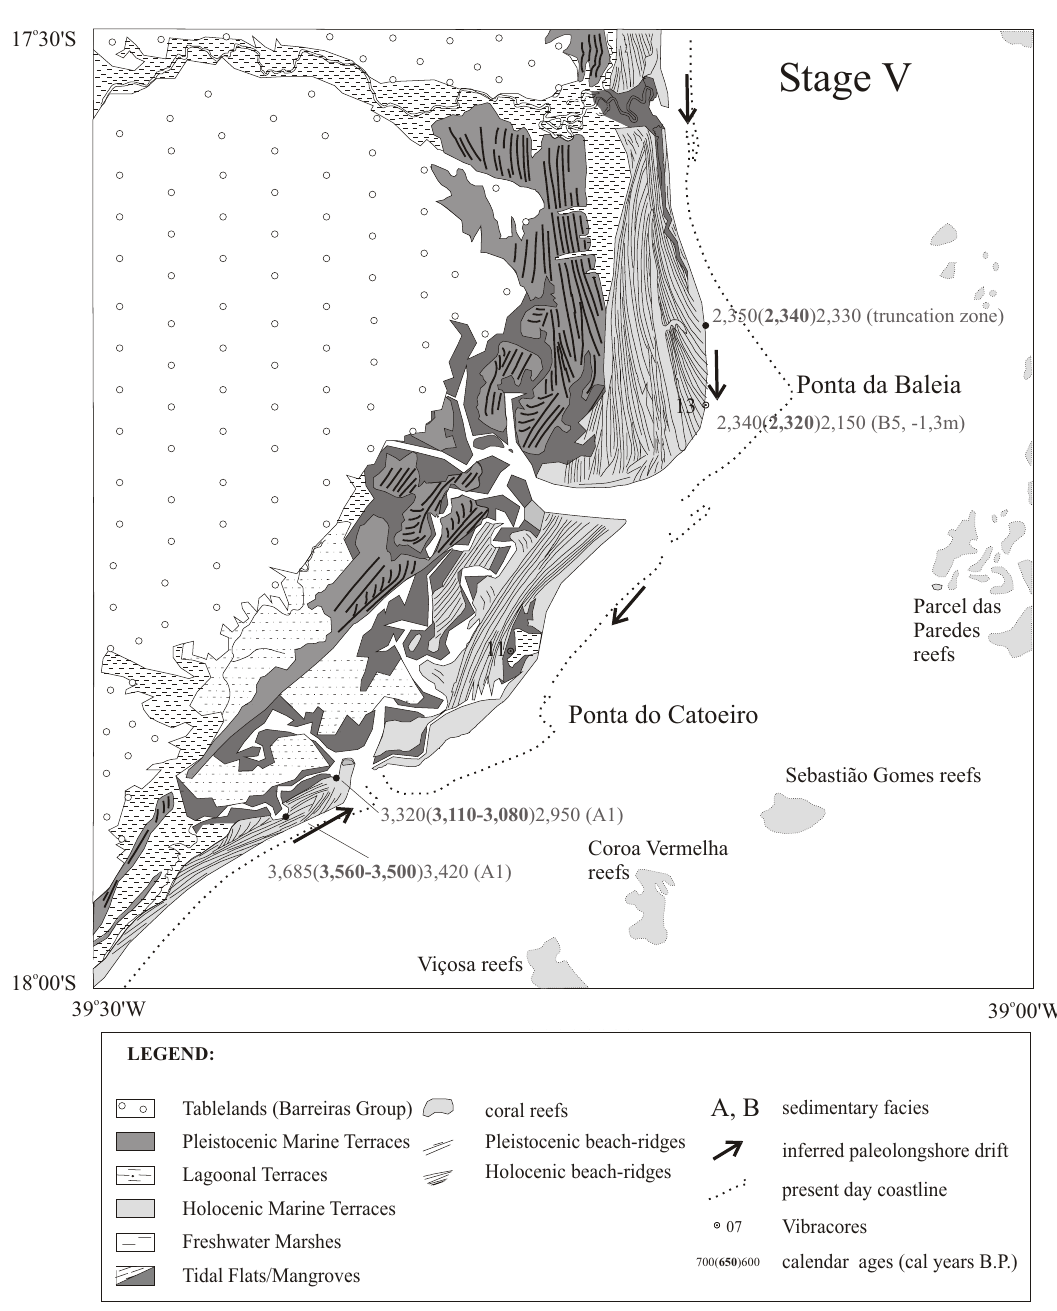
Fig. 13 – Quaternary evolution of the Caravelas strandplain: StageV – The erosional episode associated with the 2,100 cal. years B.P. (2,400 years C 14 B.P) rapid rise in relative